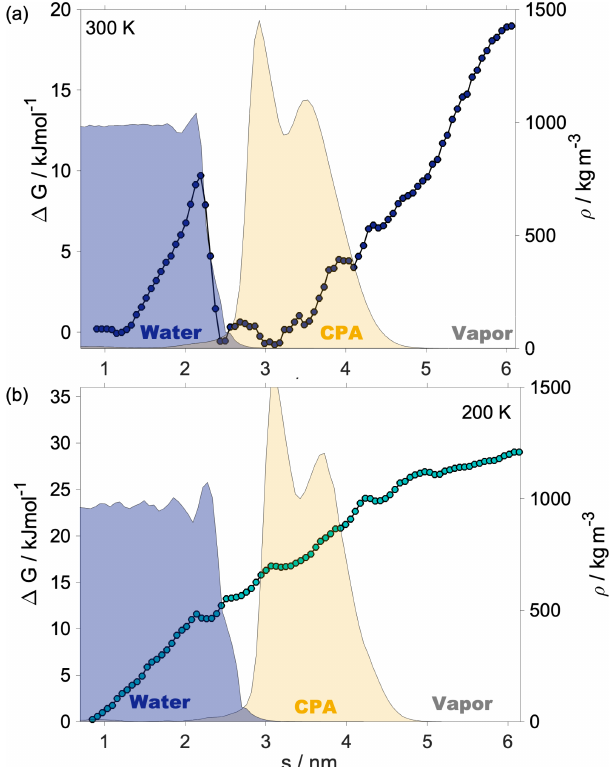
Figure 2. (a) Free-energy and density profiles at T = 300K; (b) the same profiles at T =